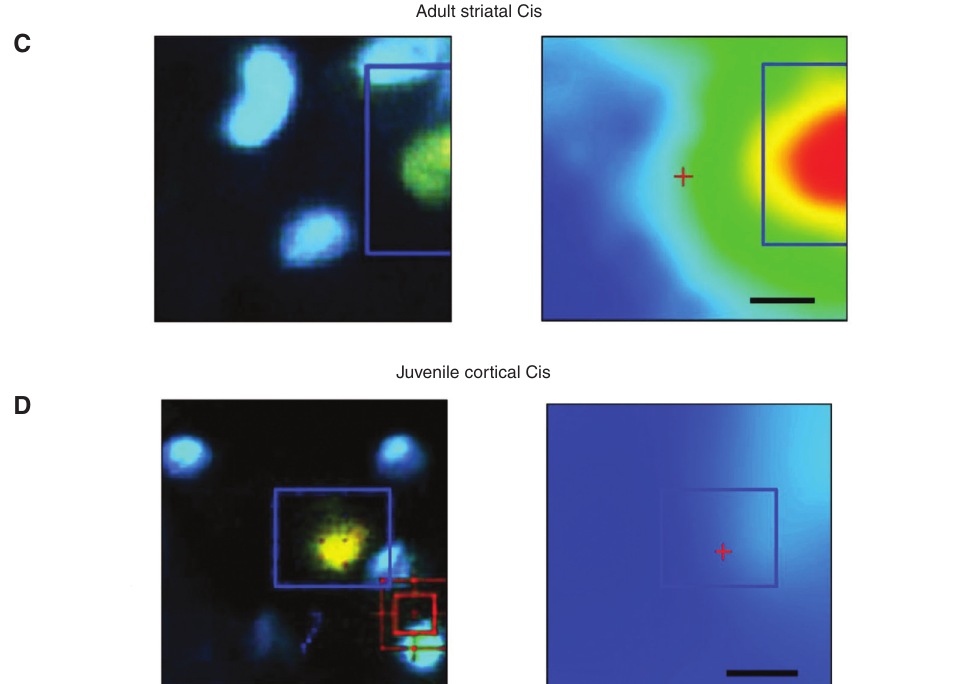
Figure 3 Synchrotron-FTIR analysis of inclusions in Huntington’s disease brain. (A) IR analyses of cortical Cis of one representative adult case and of striatal Cis of another representative adult case are illustrated. Spectra of Cis are compared to spectra of cytoplasm. Average spectra of Cis (red) and cytoplasm (black), spectra of Cis most divergent from cytoplasm (green), and corresponding secondary spectra (with same colors) are displayed. (B) IR analyses of cortical Cis of one juvenile patient and of Nis of another juvenile patient are illustrated. Spectra of Nis are compared to spectra of nuclei; analysis is performed as in (A). Arrowheads mark enrichments in peaks assigned to β -sheets at 1627 cm -1 , 1681 cm -1 , and 1693 cm -1 . The peak at 1627 cm -1 indicates the amyloid nature of adult Cis and juvenile Nis; absence of this peak in juvenile Cis shows their nonamyloid nature. Arrows in striatal adult Cis and cortical juvenile Nis reveal additional contribu- tion of a peak assigned to β -sheet/unordered structure at 1639 cm -1 . Therefore adult Cis and juvenile Nis possess amyloid structures with distinct characteristics (a component at 1639 cm -1 ). (C) Chemical map of β -sheet content of an adult striatal Cis. (Left panel) Fluorescent labeling of Cis (green) and nuclei (blue). (Right panel) β -sheet/ α -helix ratio displayed by color scale going from red (highest) to blue (lowest or nil). Correspondence between inclusion and area with highest β -sheet content is obvious. (D) Chemical map of β -sheet content of cortical juvenile Cis. (Left panel) Fluorescent labeling of Cis (yellow) and nuclei (blue). (Right panel) β -sheet/ α -helix ratio. No increase in β -sheet content is observed in inclusion. Scale bars: 2 μ m. (A), (B), and (C) reproduced and adapted from André et al.